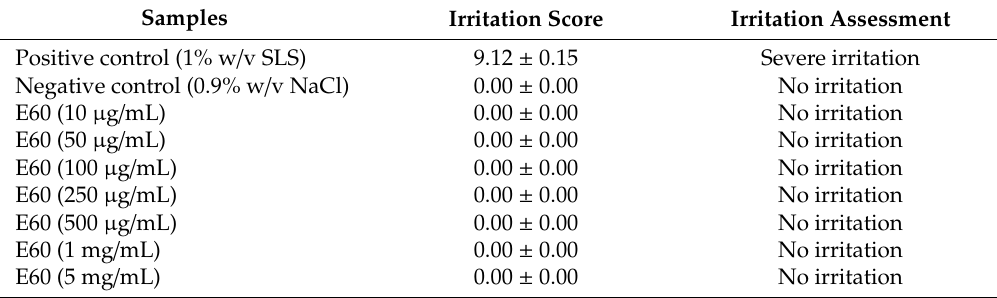
Table 1. Irritation score and irritation assessment of Sripanya pomegranate peel extract by the HET–CAM method.